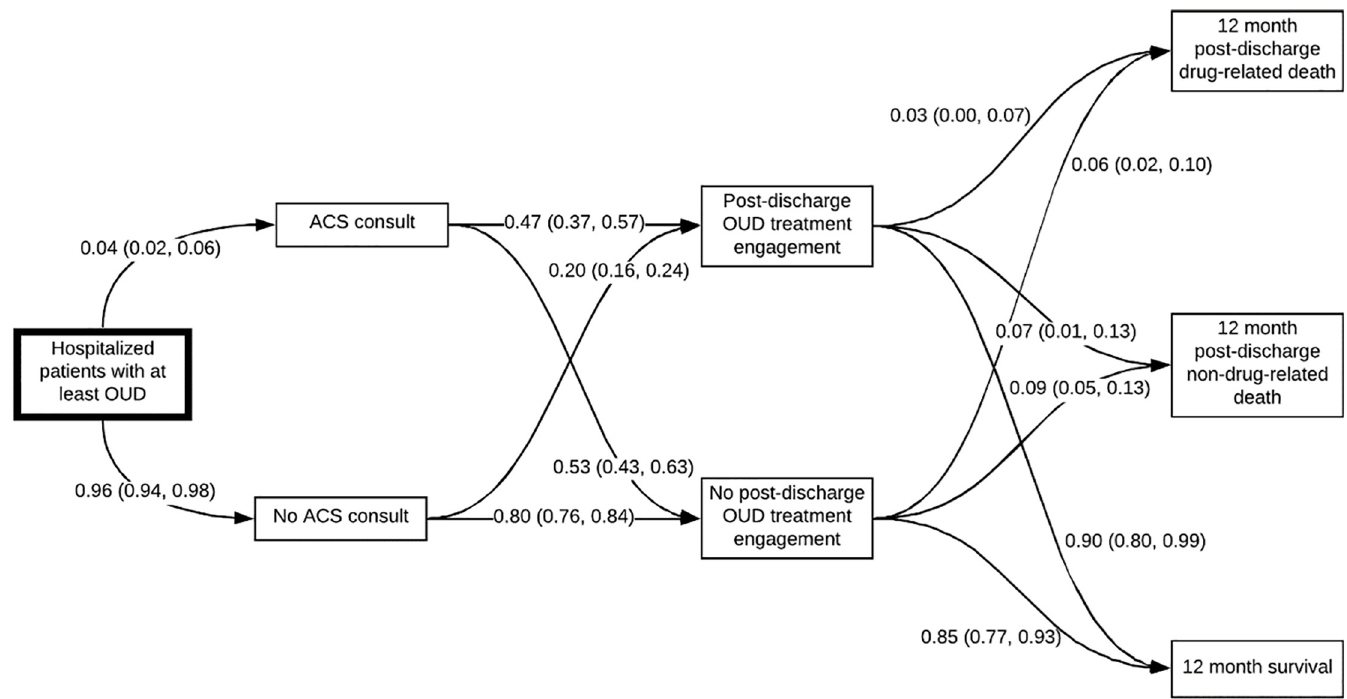
Fig 2. Markov model with estimated transition probabilities for hospital-based addiction care in Oregon,